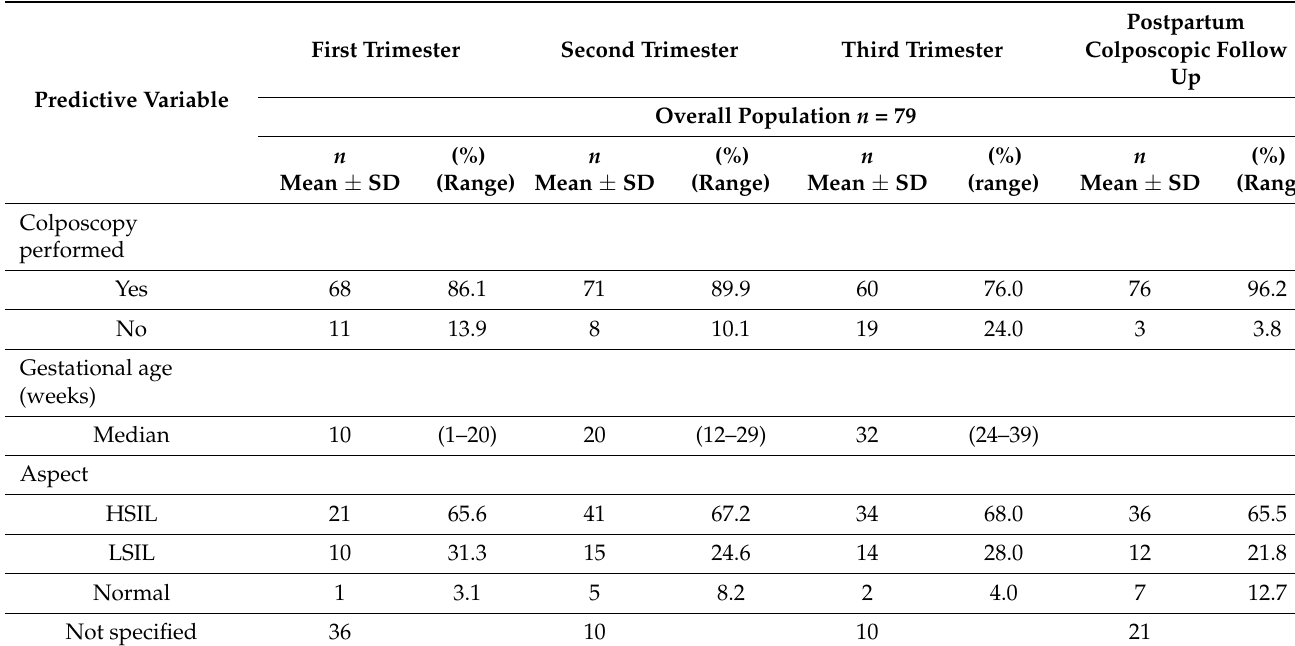
Table 2. Colposcopy-related patient characteristics by